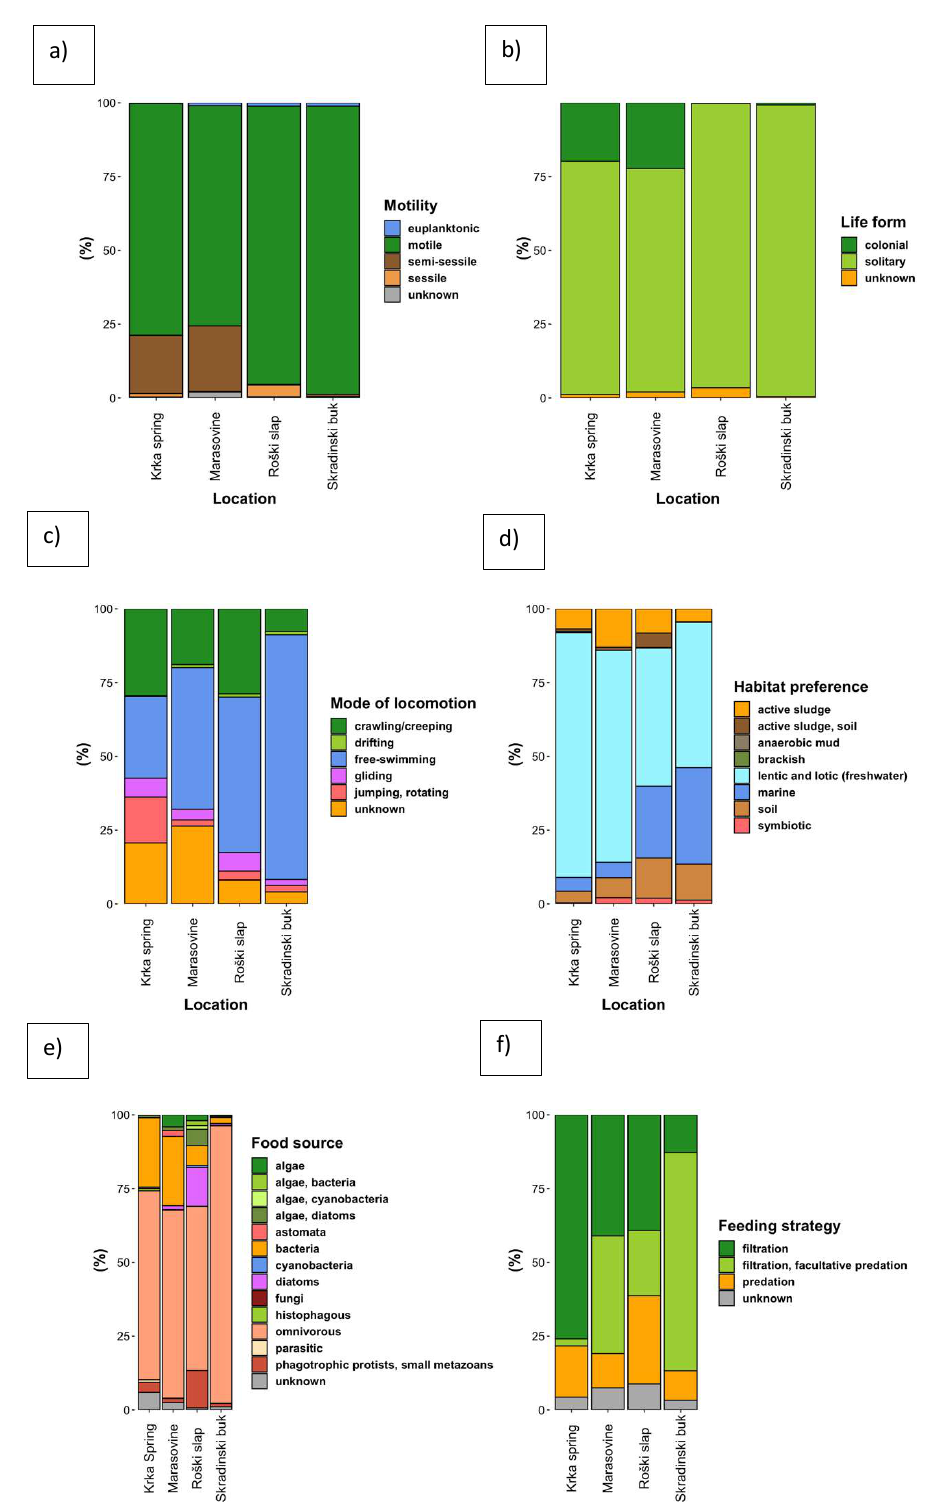
Figure 4. Proportion of functional groups with regard to ( a ) motility; ( b ) life form; ( c ) mode of locomotion; ( d ) habitat preference; ( e ) food source; ( f ) feeding strategy at each of the four sampling locations: Krka spring, Marasovine, Roški slap and Skradinski buk.